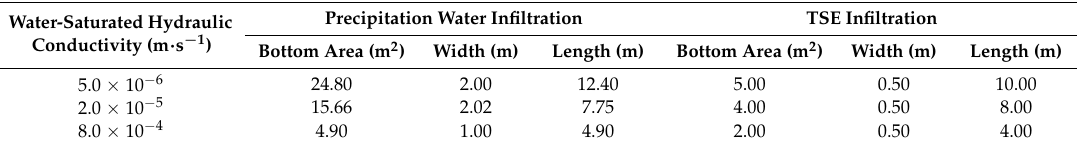
Table 3. Spatial extents of the infiltration ditches for precipitation and TSE infiltration, respectively. Height of the precipitation water ditch and TSE infiltration ditch was kept at 2.5 m and 0.5 m,